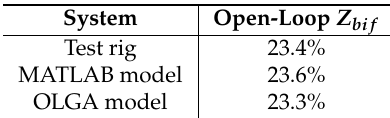
Table 2. The open-loop bifurcation point ( Z bif ) comparison between the actual measurements from the test rig to the two models. When the models were tuned to fit the data, Z bif had the highest priority. Thus Z bif is close to reality for both